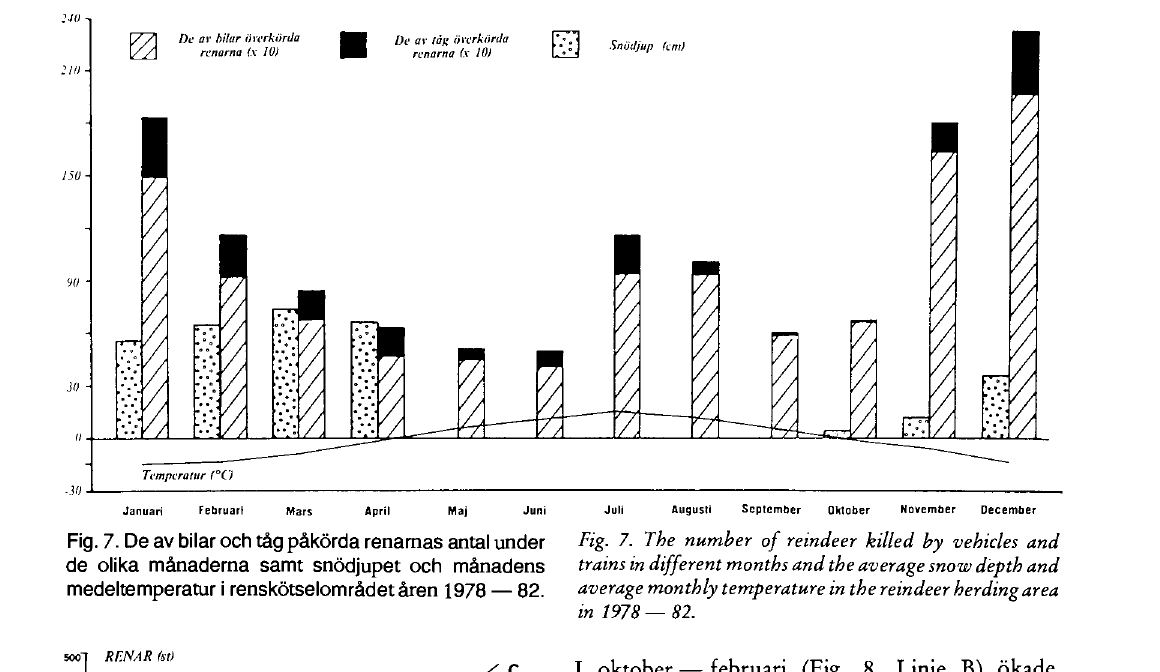
Fig. 7. De av bilar och tåg påkorda renarnas antal under de olika månaderna samt snodjupet och månadens medeltemperatur i renskotselområdet åren 1978 — 82.